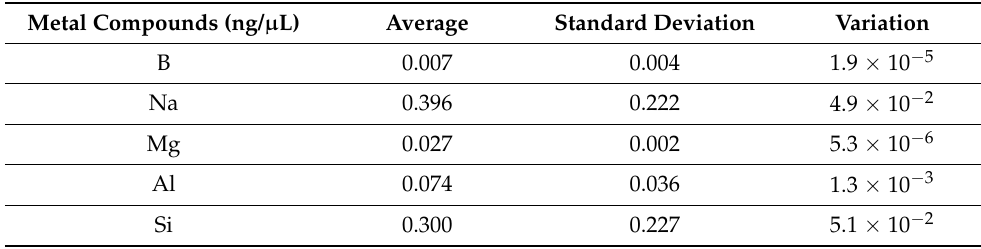
Table 4. Metal components in the tire samples. Metal Compounds (ng/ μ L)